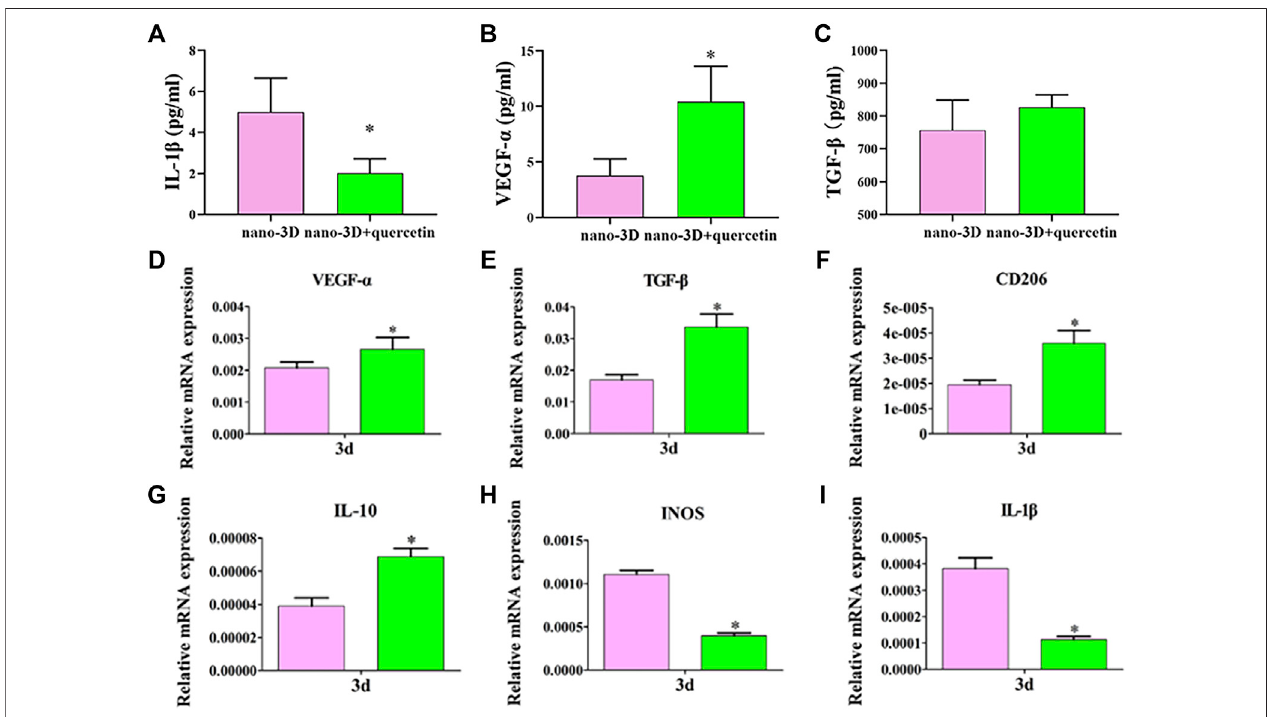
FIGURE 3 | Elisa results of IL-1 β , VEGF- α and TGF- β at 24 h respectively (A – C) and relative genes expression of RAW 264.7 (D – I) on nano-3D and nano-3D + quercetin samples at 3 days (* p < 0.05).